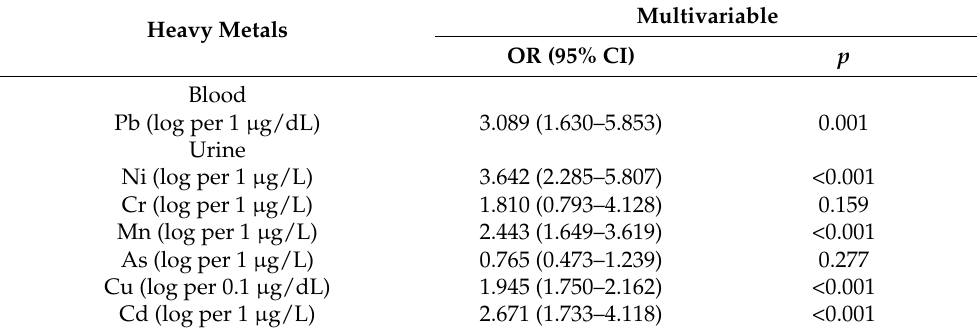
Table 2. Association of heavy metals with proteinuria using multivariable logistic regression analysis.